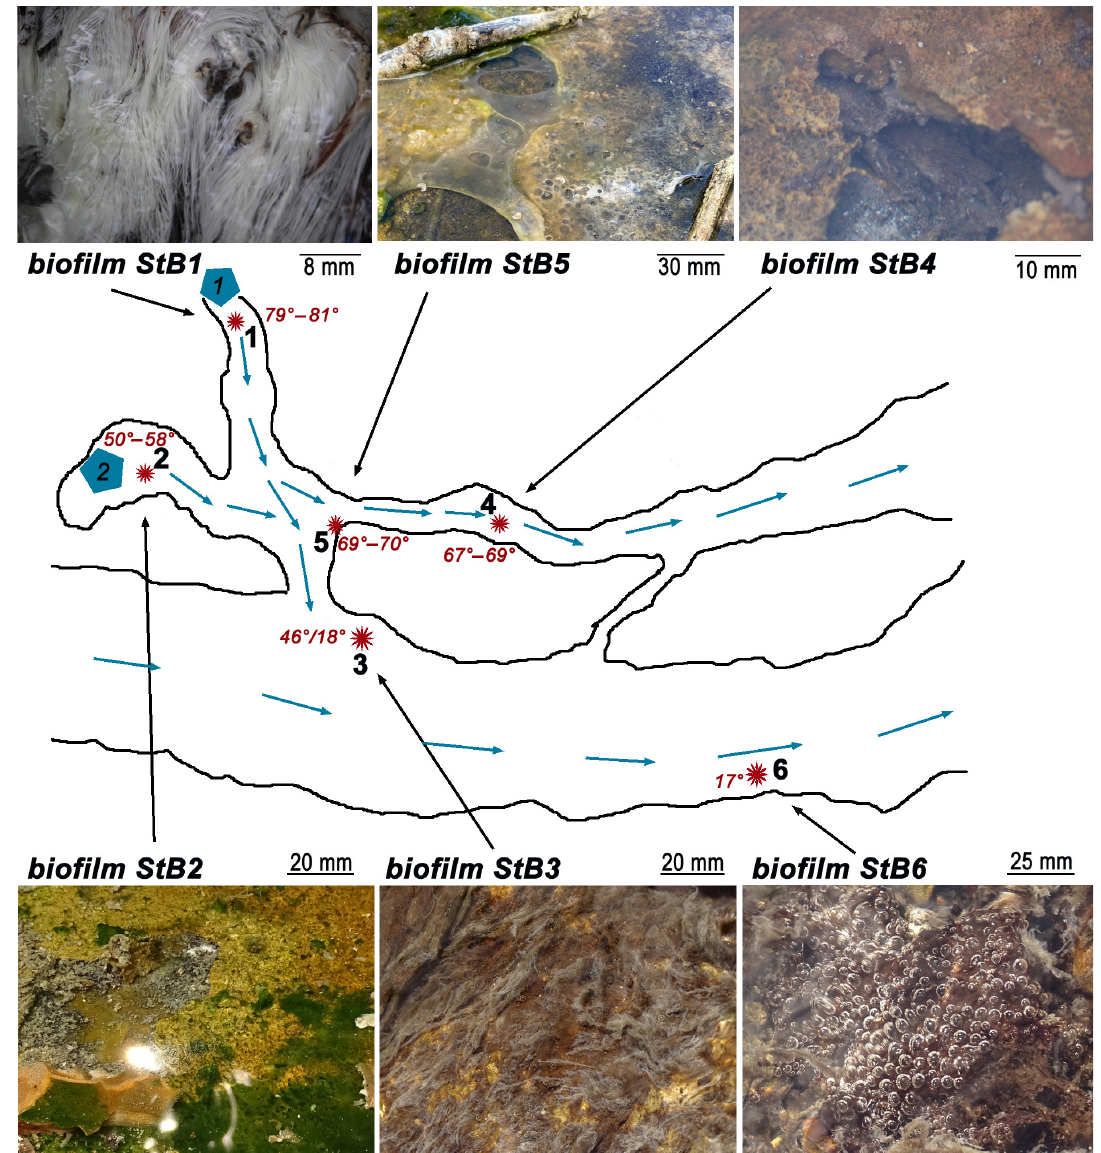
Figure 1. Scheme of the sampling site at the Stolbovskie hot springs, and photographs of the studied biofilms. Blue polygons—hot springs; red asterisks—sampling points; blue arrows show direction of water flow. The distances between sampling sites: from site 1 to site 5 5.0 m; from site 2 to site 5 4.5 m; from site 3 to site 5 3.5 m; from site 4 to site 5 4.0 m; from site 3 to site 6 15 m.